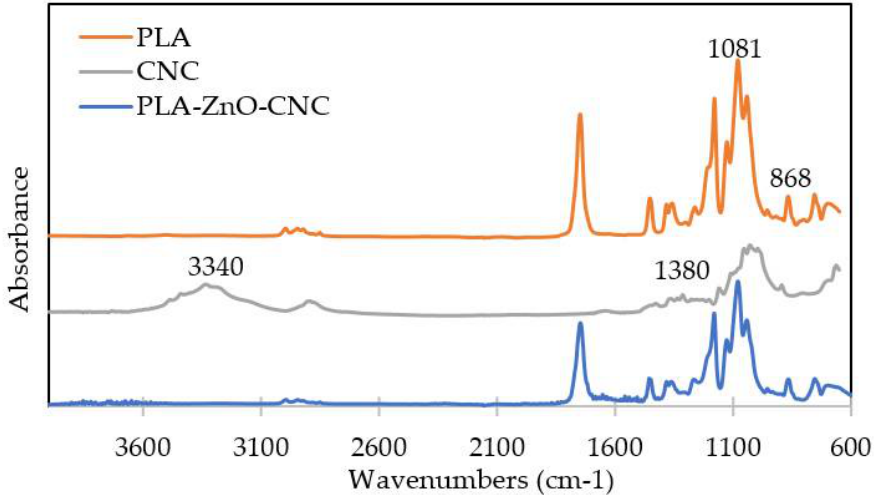
Figure 3. Infrared spectra of polylactic acid, cellulose nanocrystals, and a composite with nano-zinc oxide.